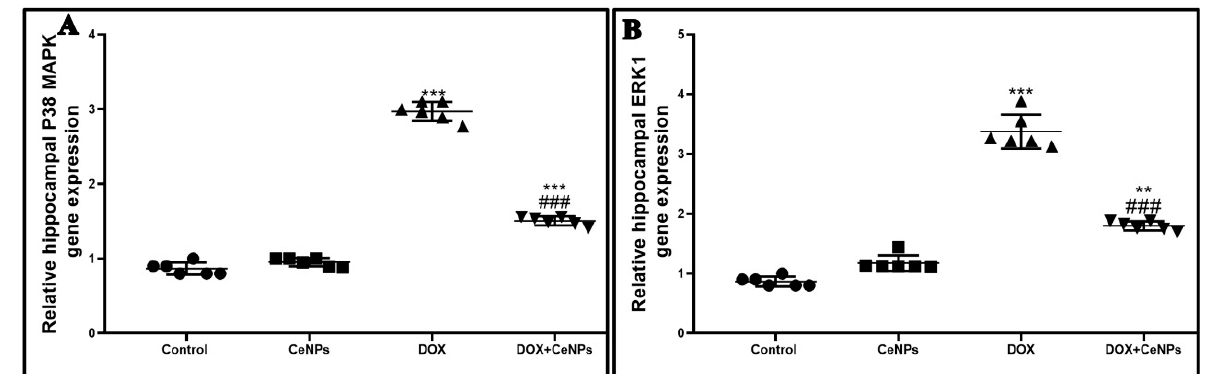
Figure 12. Impact of nanoceria administration on relative gene expression of P38 MAPK and ERK1 in different groups of rats. All data are presented as mean ± SD. The mean comparison was conducted employing by one-way ANOVA test followed by Tukey’s post hoc test, *** p < 0.001, ** p < 0.01, and * p < 0.05 vs. control group, ### p < 0.001, ## p < 0.01, and # p < 0.05 vs. DOX